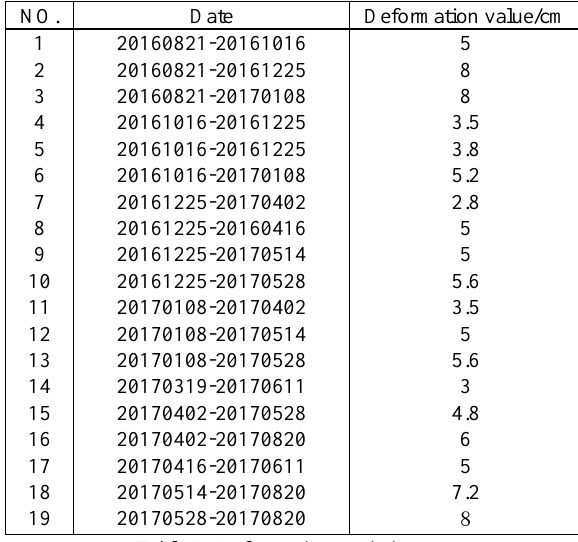
Figure 6. The result of the DInSAR Xintan Town The analysis of the 26 differential interferograms can summarize the changes of the landslide body within one year as Table 3 follows. Can be divided into three time segments 。 NO.